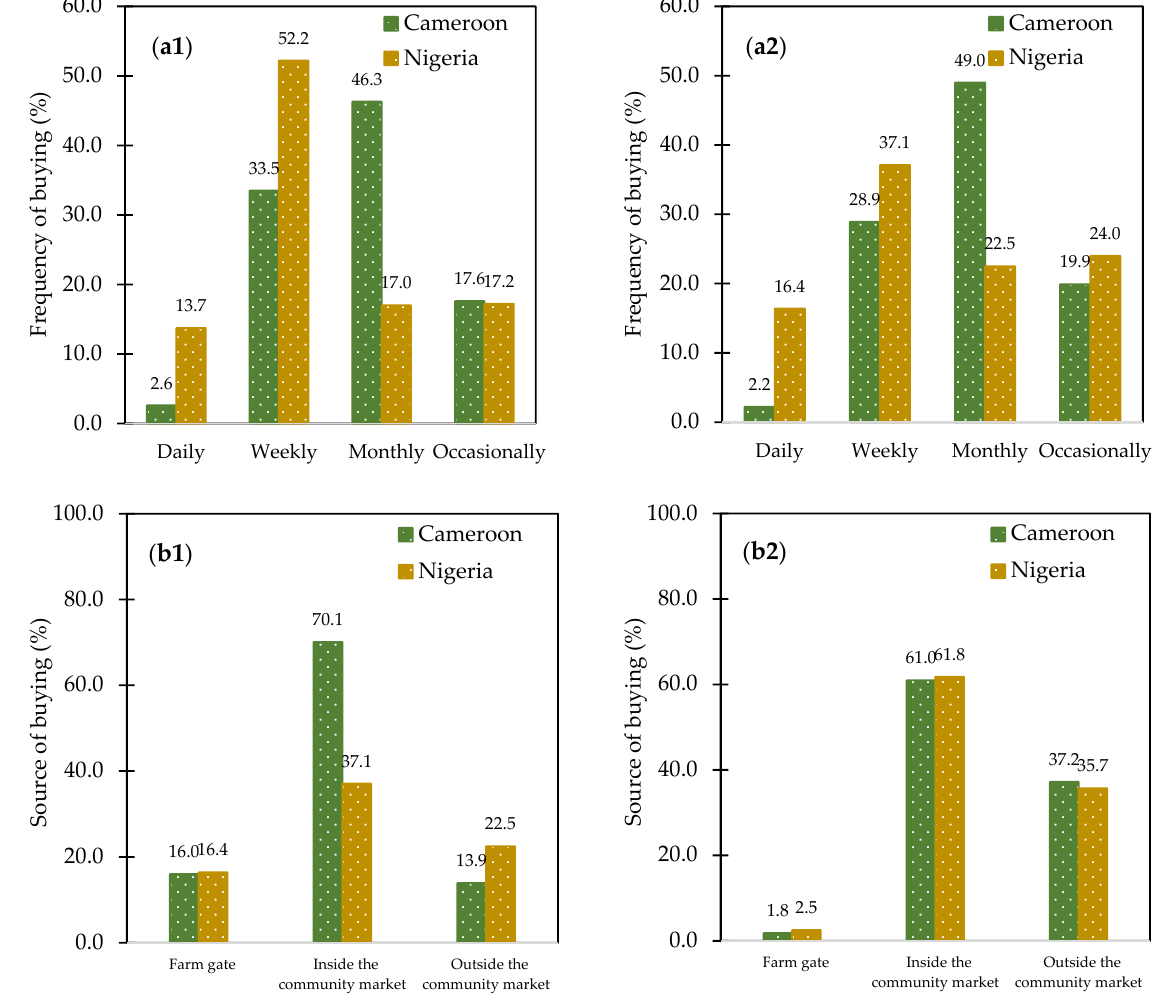
Figure 2. Frequency ( a ) and source ( b ) of buying fresh plantain ( 1 ) and plantain-based products ( 2 ) in Cameroon ( n = 454) and Nigeria ( n = 418).